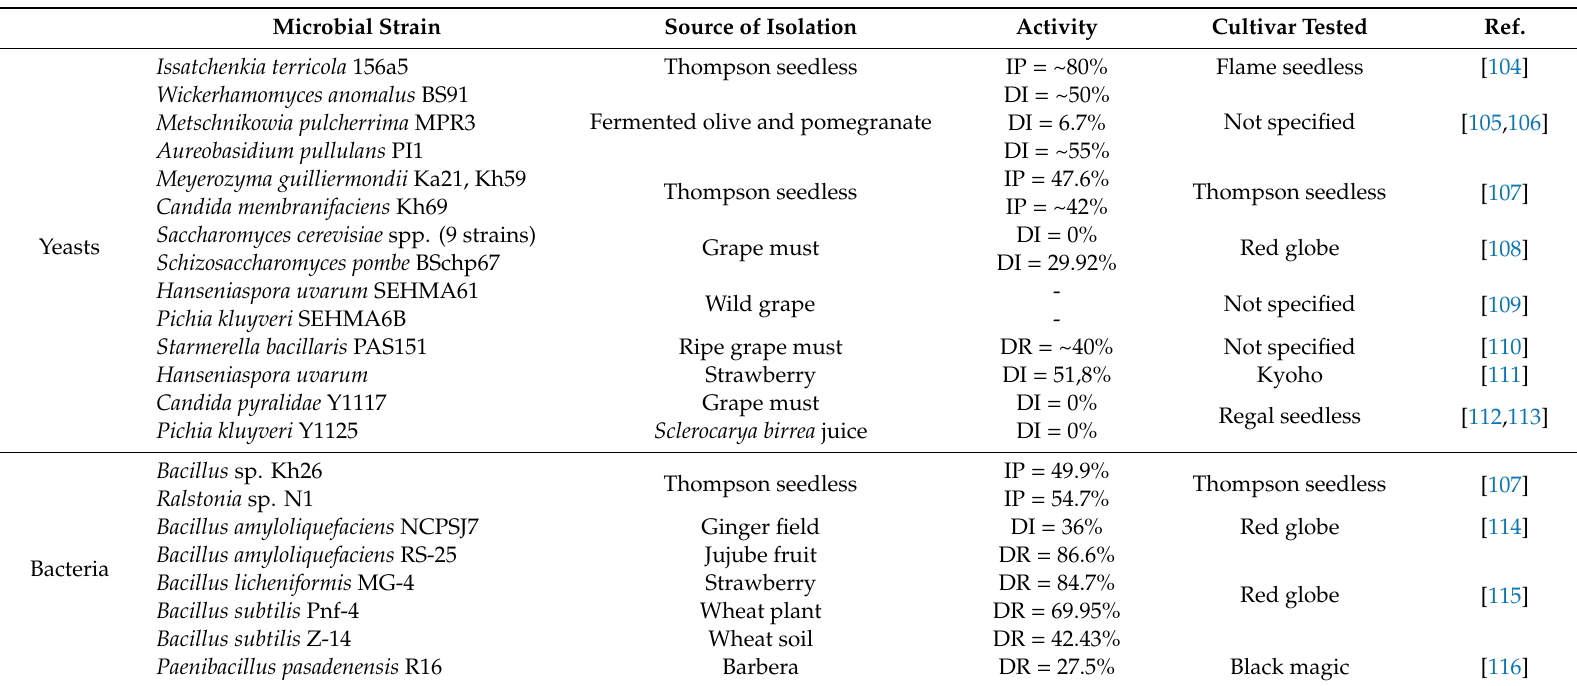
Table 3. Main microbial strains investigated in the last ten years against grey mould decay in table grapes. Where possible, Inhibition Percentage (IP), Disease Incidence (DI), and Disease Reduction (DR) were reported to quantify the activity of each